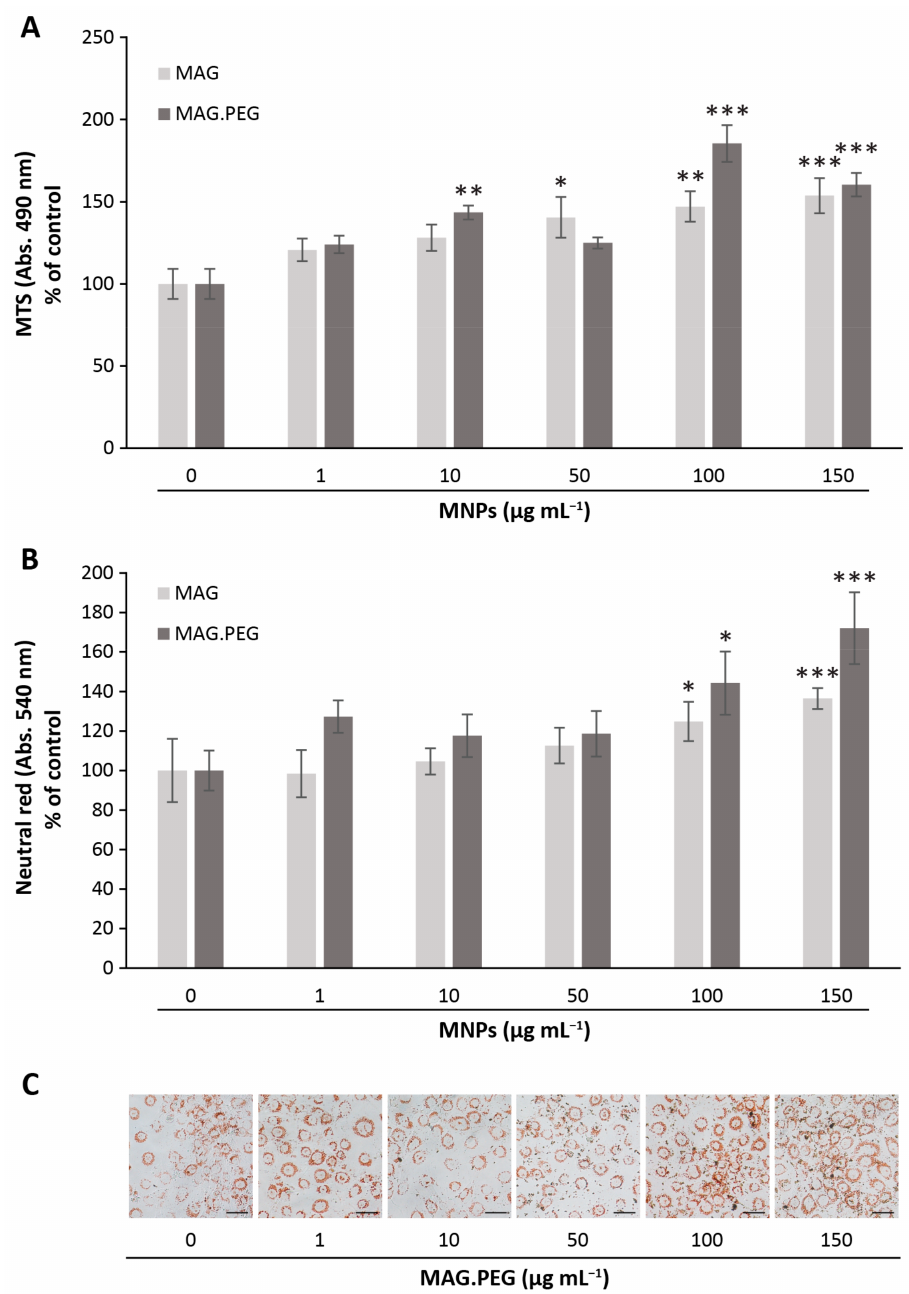
Figure 4. Cell viability assays . The vGPCR cells were incubated with different concentrations of MNPs (1–150 µ g mL − 1 ) or distilled water as control for 48 h. ( A ) The metabolic activity of the cells was measured by MTS as described in the Methods section. Absorbance was measured at 490 nm. The data is presented as the percentage of control ± SD. N = 3. ( B ) Lysosomal activity of the cells was measured by neutral red assay as described in the Methods section. Absorbance was measured at 540 nm. The data is presented as the percentage of control ± SD. N = 5. ( A , B ) Significant differences between control and MNPs conditions were evaluated by ANOVA and Dunnett post hoc tests, and are indicated as * p < 0.05, ** p < 0.01, and *** p < 0.001. ( C ) Representative micrographs of the cells incubated with different concentrations of MAG.PEG and stained with neutral red were obtained by a phase contrast microscope. Scale bar = 50 µ m. Magnification 200 ×